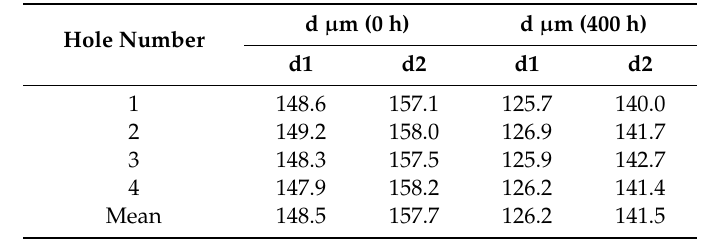
Figure 6. Surface from the head of the piston 1: ( a ) before the experiment (0 h); and ( b ) after the experiment (400 h) using 50PF50D. Table 5. Dimensions measured from the injector nozzle holes before (0 h) and after (400 h) the experiment using 50PF50D.